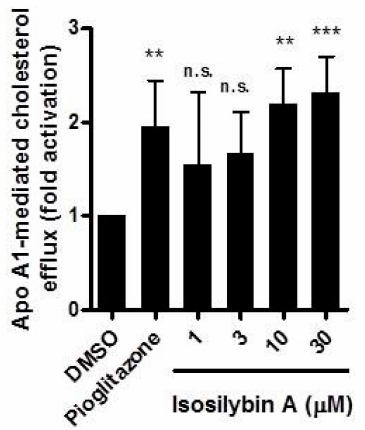
Figure 3. Effect of isosilybin A, a partial PPAR γ agonist, on apo A1-mediated cholesterol efflux. First, THP-1 monocytes were differentiated into adherent macrophages by treatment with 200 nM PMA for 72 h. The differentiated THP-1 macrophages were loaded with [ 3 H]-cholesterol together with solvent vehicle control (DMSO), pioglitazone (10 µ M) and varying concentrations of isosilybin A (from 1 to 30 µ M) in serum-free medium with 0.1% fatty acid free BSA and 10 µ g/mL unesterified cholesterol for 24 h to achieve equilibration of the intracellular cholesterol pool. After that, cells were incubated with the same treatments with or without 10 µ g/mL apo A1 dissolved in serum-free medium for 6 h. The [ 3 H]-cholesterol released into the medium as well remaining in the cell lysates was quantified by liquid scintillation counting. Three independent experiments were performed. All values are mean ˘ SD ( n = 3) compared to the solvent vehicle control (DMSO), n.s.: not significant, ** p < 0.01, *** p < 0.001